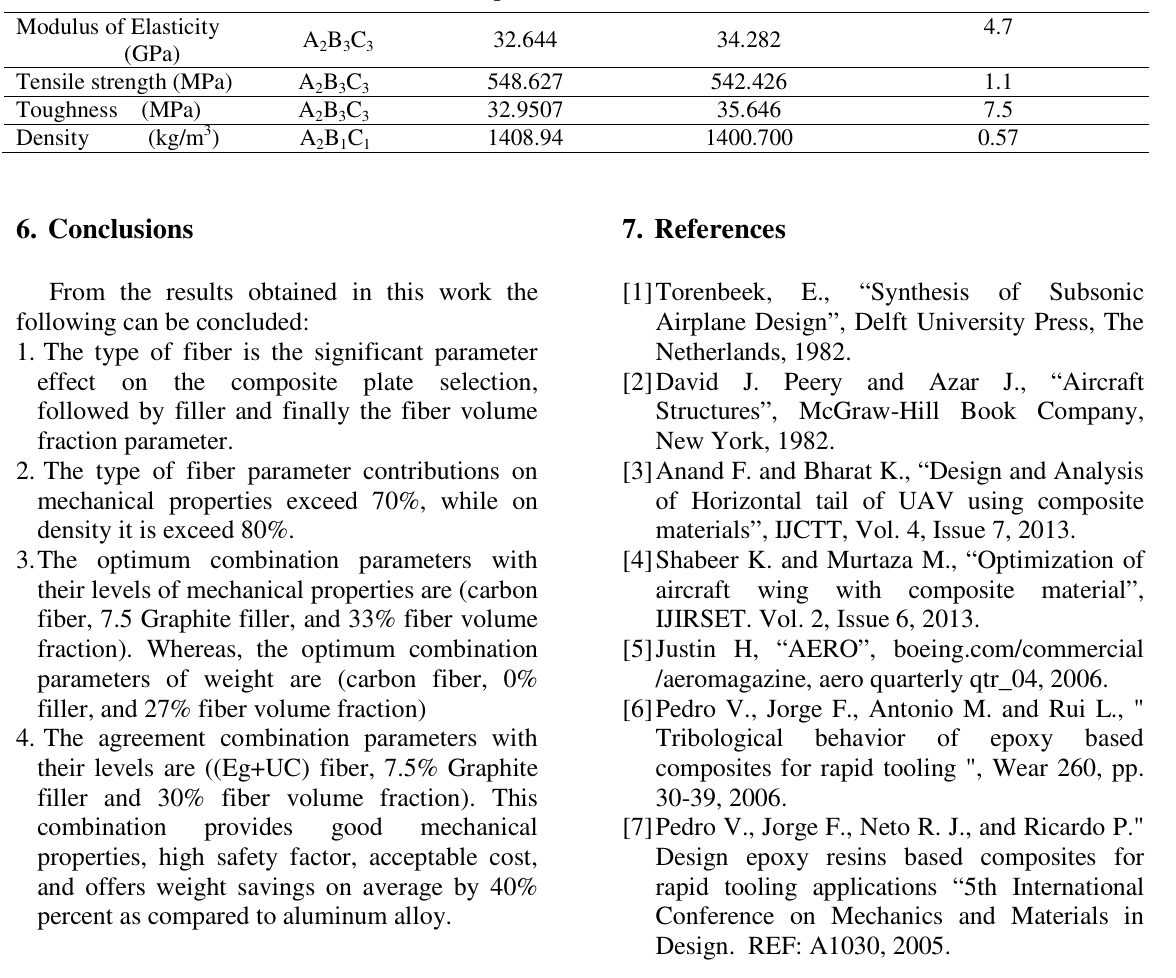
Confirmation results characteristic Modulus of